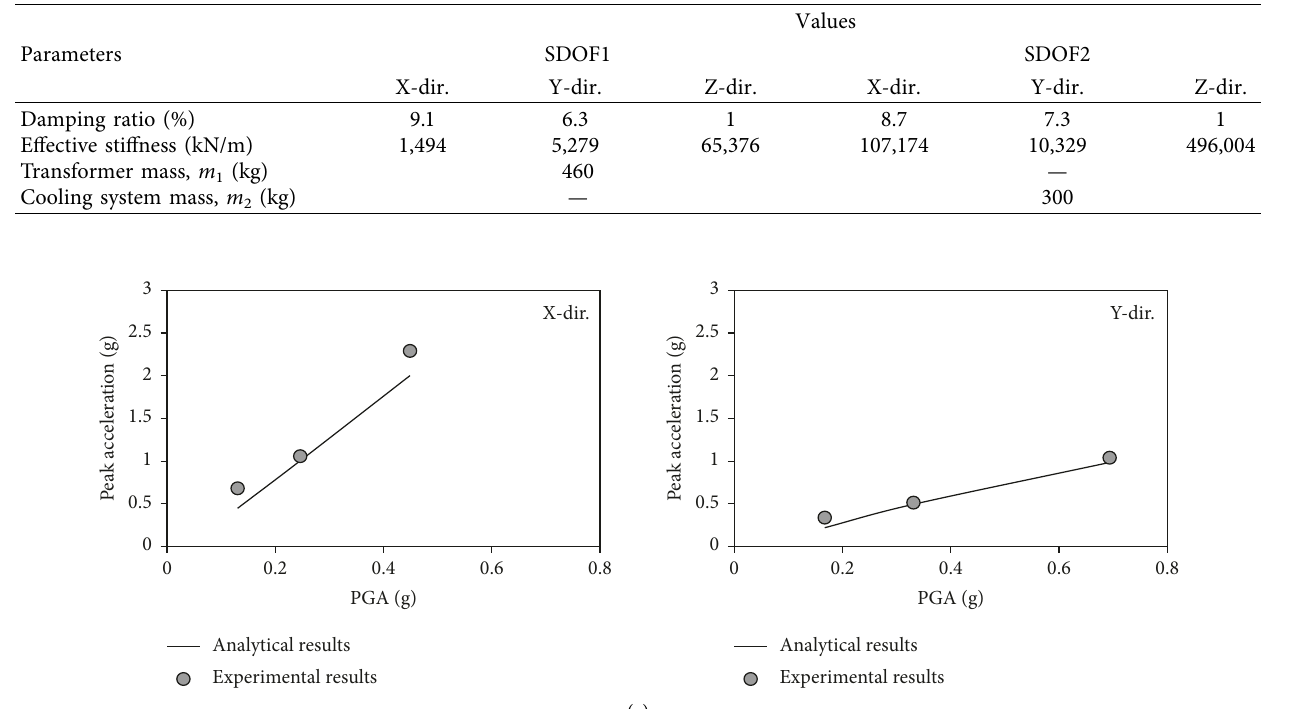
Table 7: Dynamic parameters of the UPS.